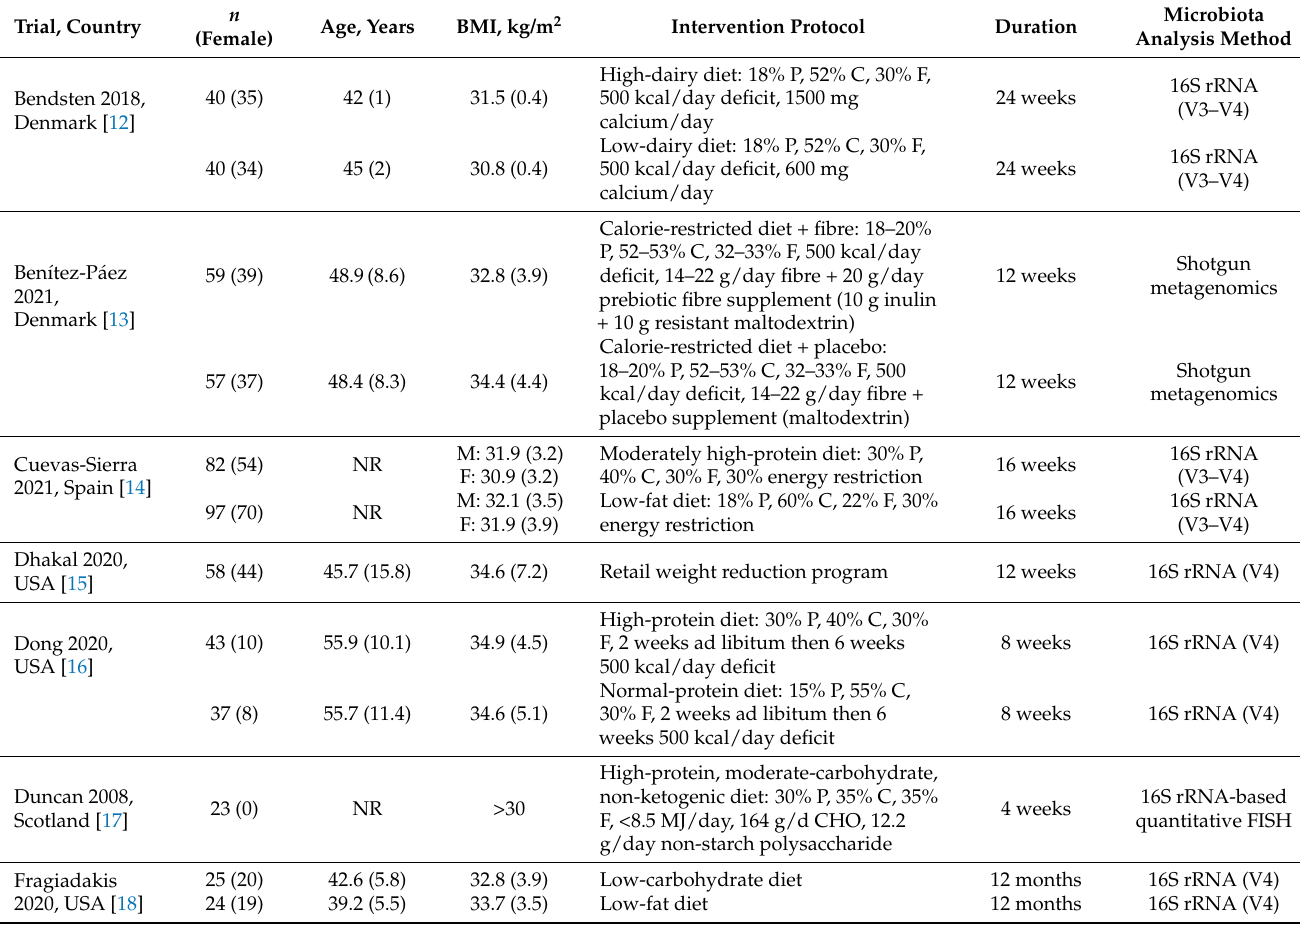
Table 1. Characteristics of included